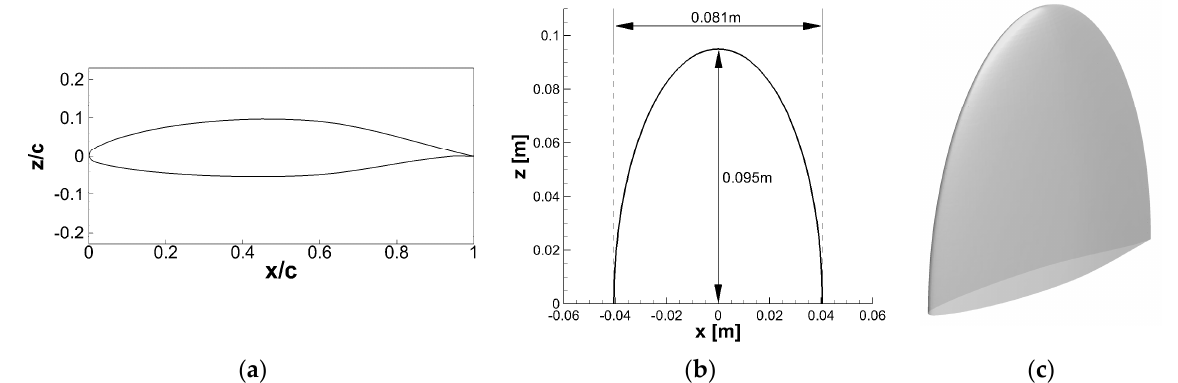
Figure 1. Foil section, elliptical profile and perspective view of the elliptic planform foil: ( a ) NACA 66 2 -415 section; ( b ) chord and span lengths; ( c ) 3D view of the foil.